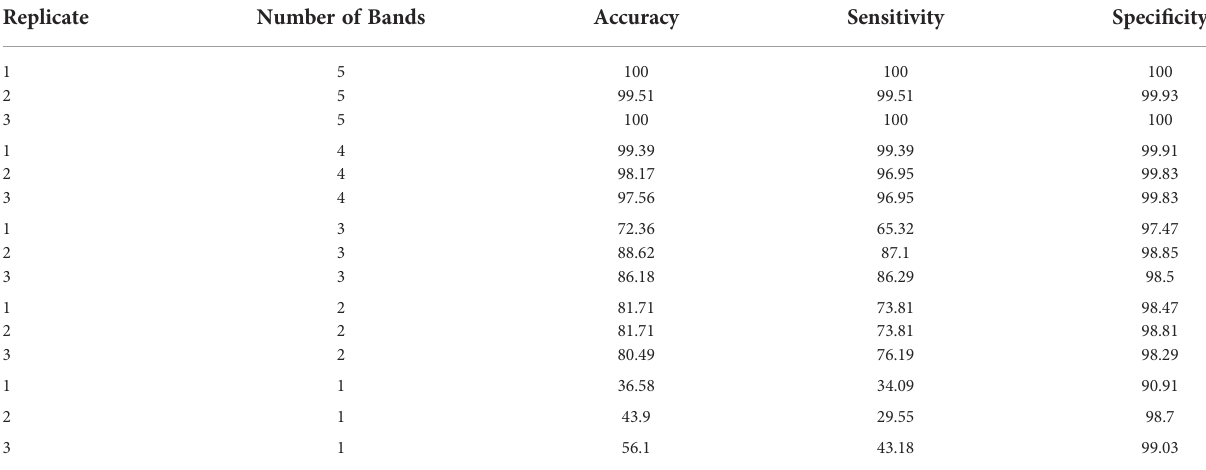
TABLE 4 Results of trained CNN with PCA-based bands. Replicate